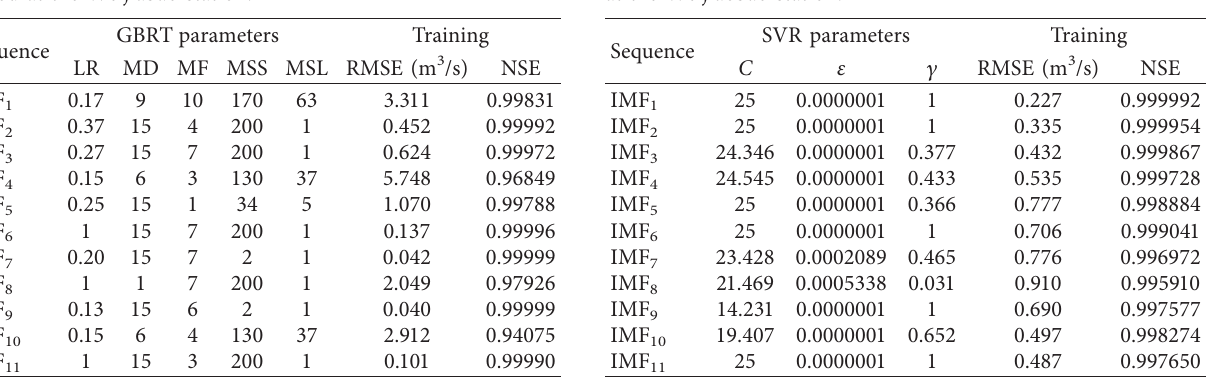
Table 3: Performance of the GBRT model during the training period at the Weijiabao station.